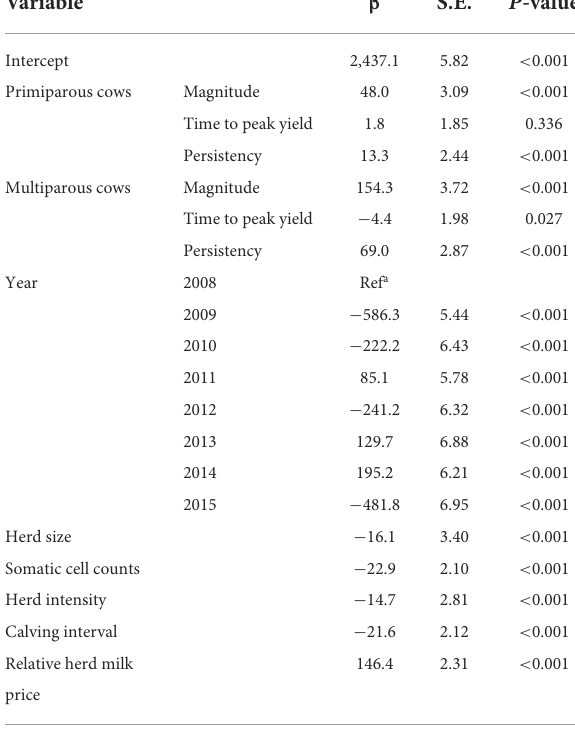
TABLE 2 Results of the final reduced linear mixed model on the association between income over feed cost per cow ( e ) and herd lactation curve characteristics (and other herd variables) based on data from 1,664 Dutch